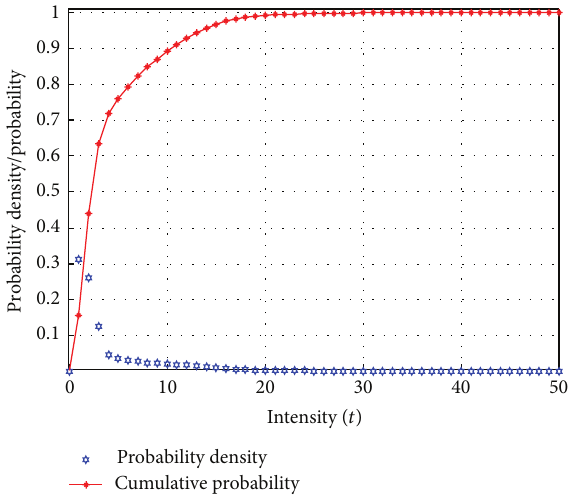
Figure 17: Different load distributions of two-axle